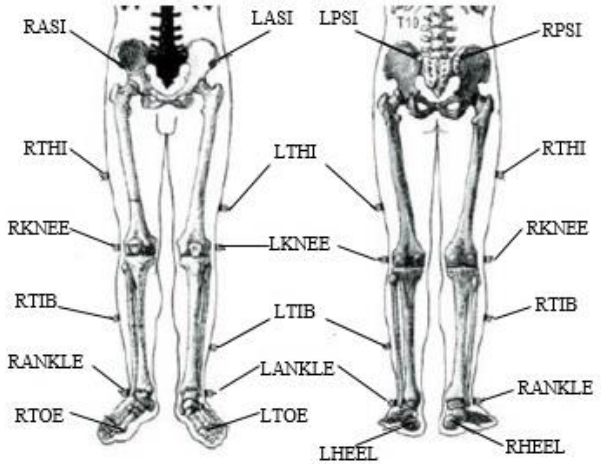
Figure 1. The placement of reflective markers at the anatomical landmarks of each subject’s lower extremities (Source: Vicon Motion System Ltd., Oxford,